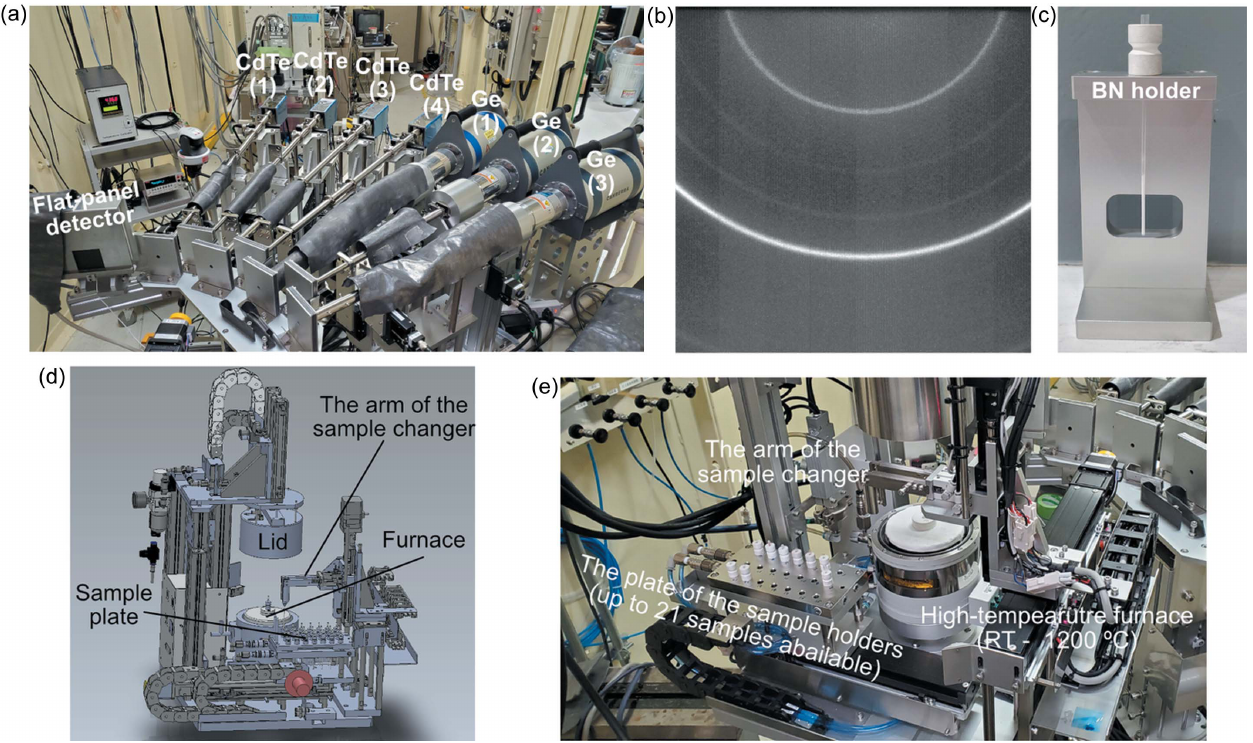
Figure 1 Experimental setup of the horizontal diffractometer and automated sample changer with a furnace in BL04B2. ( a ) Seven semiconductor detectors, and the flat-panel detector fixed on the diffractometer at around (cid:5) 15.3 (cid:2) . ( b ) Typical two-dimensional XRD pattern captured by the flat-panel detector. ( c ) Boron nitride holder containing a quartz capillary (with a diameter of 1.5 mm) and the aperture used to check the height of the sample. ( d ) Automated sample changer and furnace. Up to 21 samples can be loaded on the plate. ( e ) Photograph of the automated sample changer on the